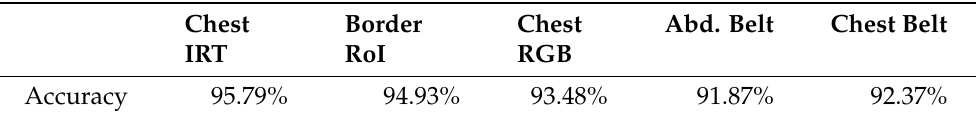
Table 5. Breathing pattern classification results for all extracted signals using a one vs. one multiclass support vector